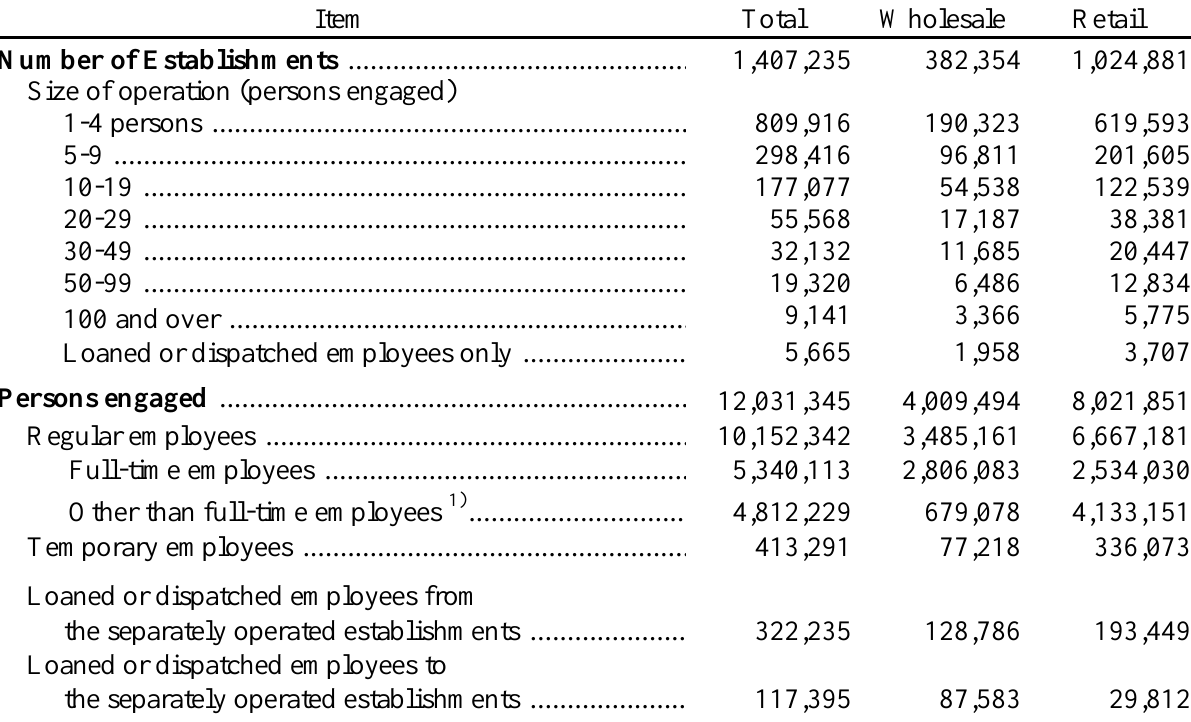
Establishments and Persons Engaged in the Wholesale and Retail Sector (2014) Item Total Wholesale Size of operation (persons